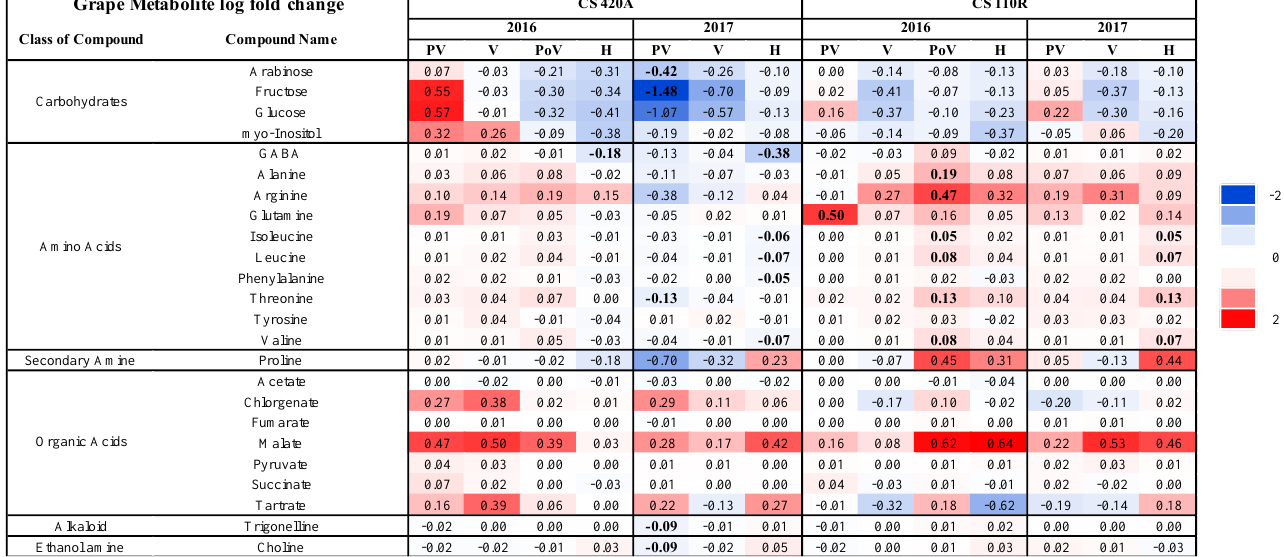
Figure 1. Log fold changes of primary metabolite concentrations through ripening in Cabernet Sauvignon grapes grafted onto 110R and 420A rootstocks in 2016 and 2017. Negative values (blue) indicate a decrease in concentration and positive values (red) indicate an increase in concentration in RB(+) grapes compared to RB(−) grapes. Color gradient indicates the size of log fold change. Values in bold indicate a significant difference ( p < 0.05, FDR correction). CS = Cabernet Sauvignon, PV = pre-veraison, V = veraison, PoV = post-veraison, and H = harvest.